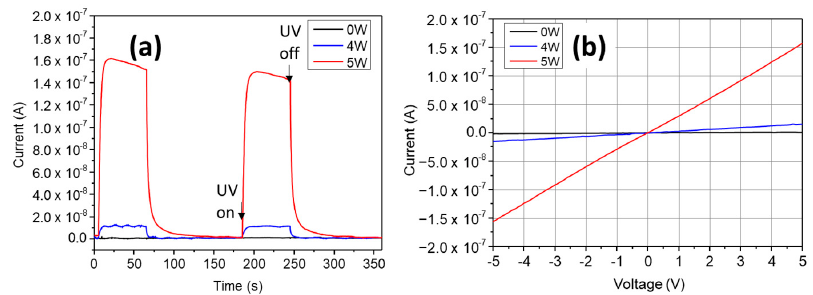
Figure 8. Photo-sensing properties of the fabricated device. ( a ) Sequential illumination of the sensor by UV light and obtained photocurrent. ( b ) I–V curve of the devices under UV illumination.